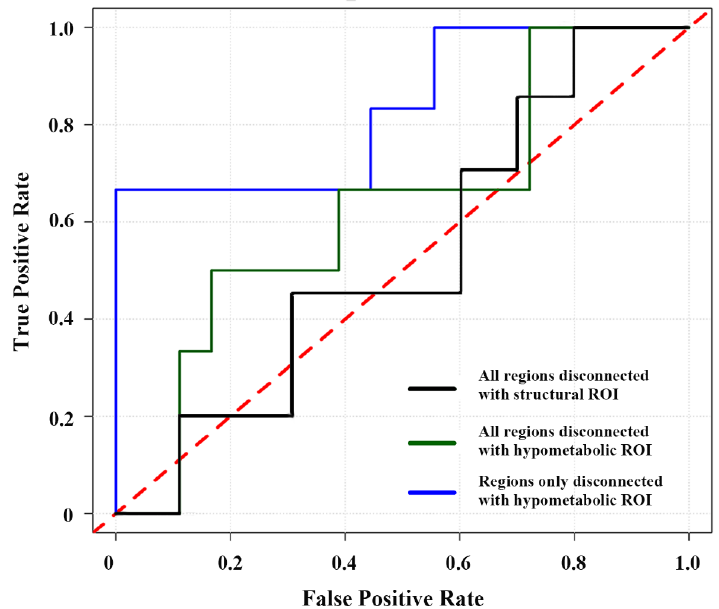
Figure 5. ROC curve evaluating the ability of FC values of brain areas reflecting decreased connection with hypometabolic or structural ROI in the prediction of surgical outcome.